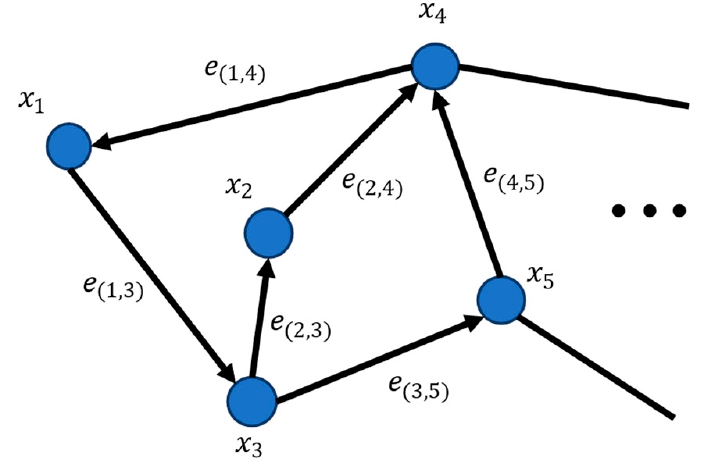
Figure 2. Graphical representation of nonlinear least-squares problems.